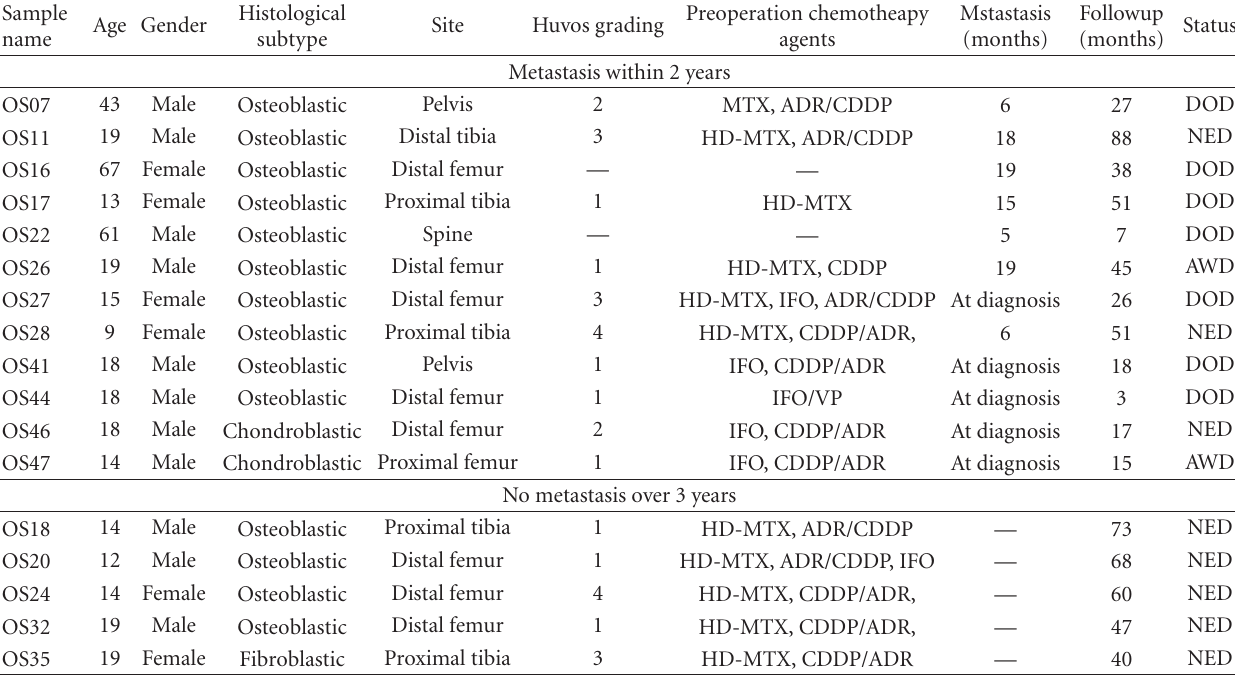
Table 5: Clinicopathological features of osetosarcoma tissue samples for prognosis study.